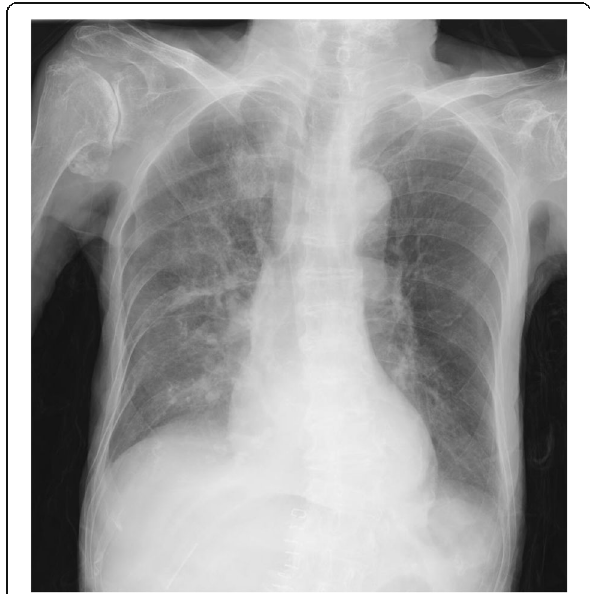
Fig. 3 Radiographic image of the adult Bochdalek hernia after operation. Chest X-ray showed no recurrence